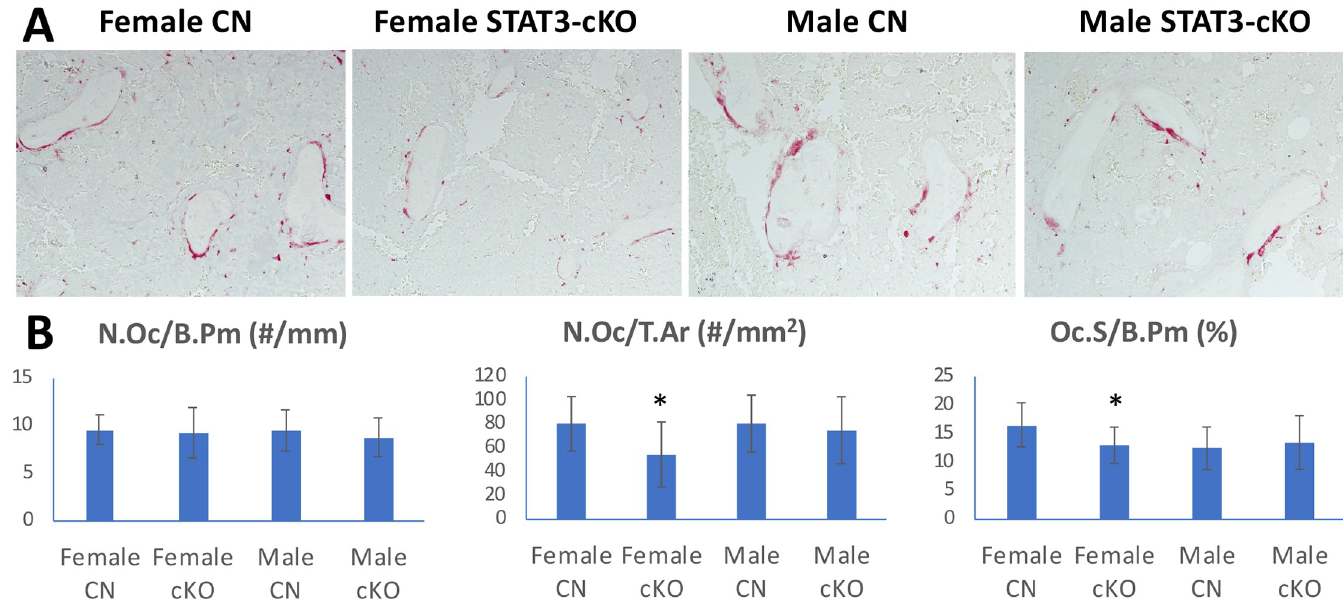
Fig 2. Tartrate Resistant Acid Phosphatase (TRAP) stain of femurs collected from 8 week old female and male control (CN) and STAT3-cKO mice. TRAP + osteoclasts (red color) of the distal femur (A) and graphical representation of osteoclast number/bone perimeter (N.Oc/B.Pm), osteoclast number/total area (N.Oc/T. Ar) and osteoclast surface/bone perimeter (Oc.S/B.Pm) (B). All data were collected from a region 0.5 mm proximal from the growth plate of the right femur ( � : p < 0.05 compared to sex-matched littermate control, n = 11-16/group).